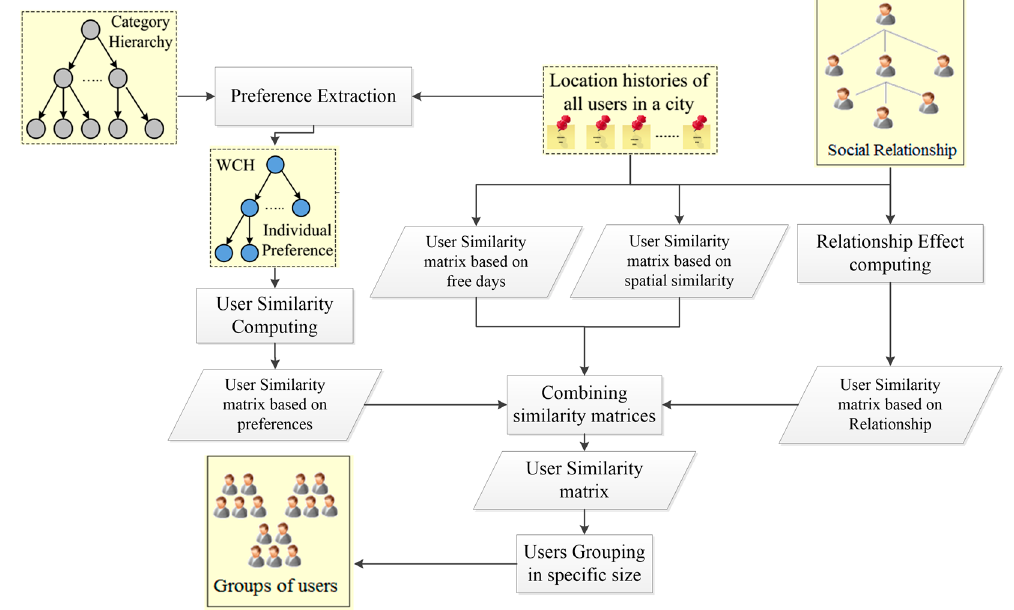
Figure 2. System architecture for automatic user